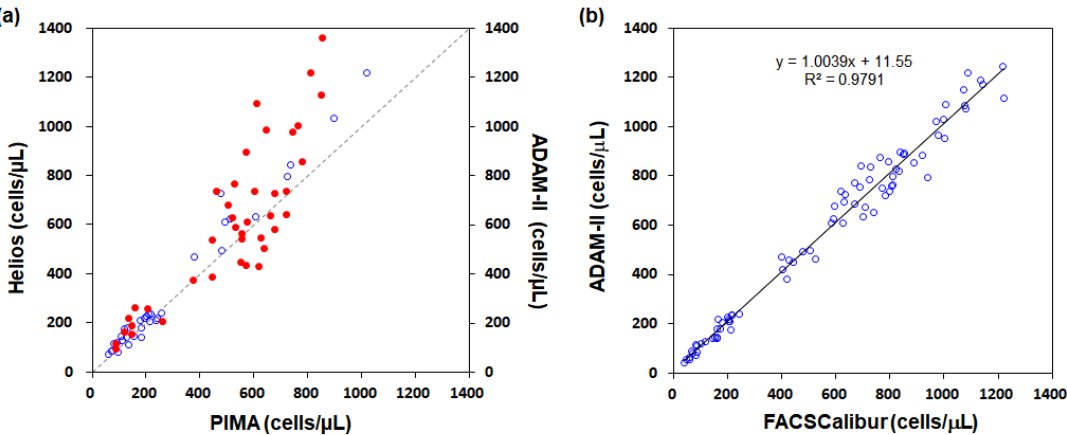
Figure 10. Comparison of CD4 + cell counts in diluted blood samples from human volunteers. ( a ) Helios and ADAM-II versus PIMA; ( b ) ADAM-II versus FACSCalibur.